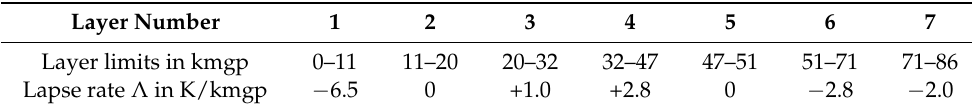
Table A1. Set of lapse rate per layer for a standard atmosphere. Layer Number 1 2 Layer limits in kmgp Lapse rate Λ in K/kmgp −